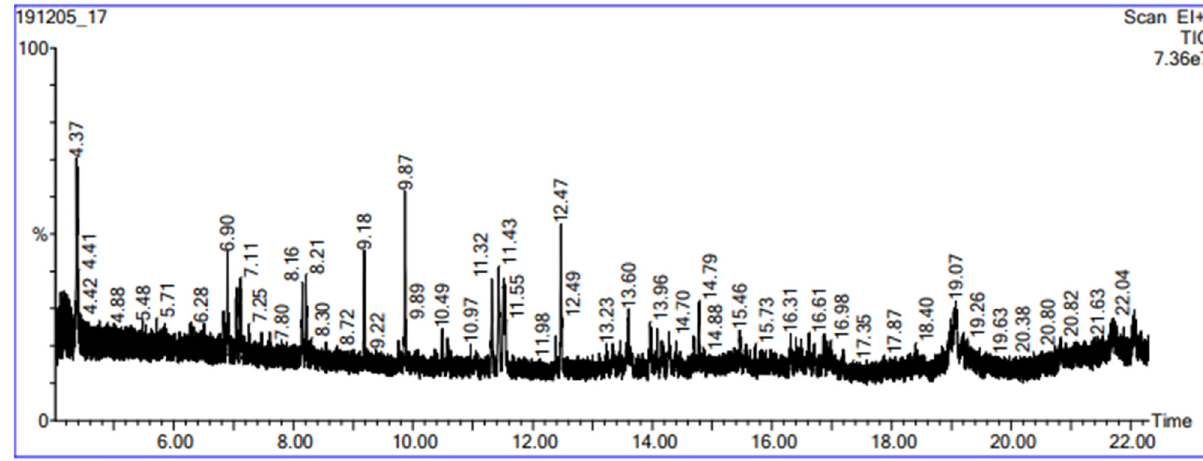
Figure 1: Chromatographic pro fi le of B. hispanica bark extract.